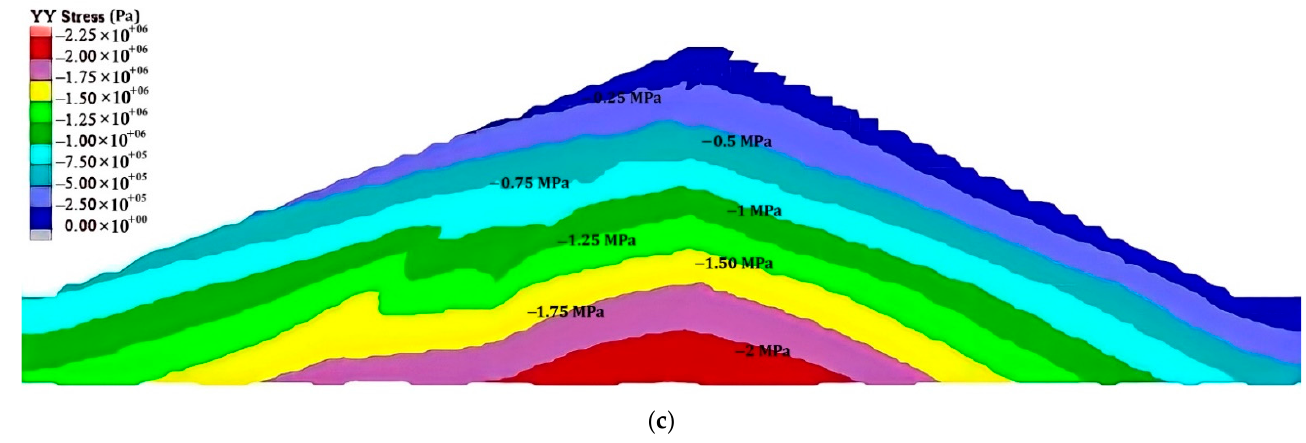
Figure 10. Contour of vertical stresses during the earthquake ( a ) 90° core, ( b ) 60° core and ( c ) 45° core.